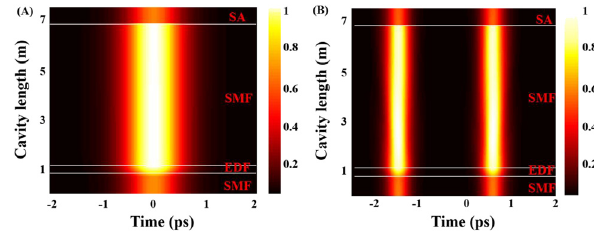
Figure 9: Simulation results of the stable pulse evolution along the